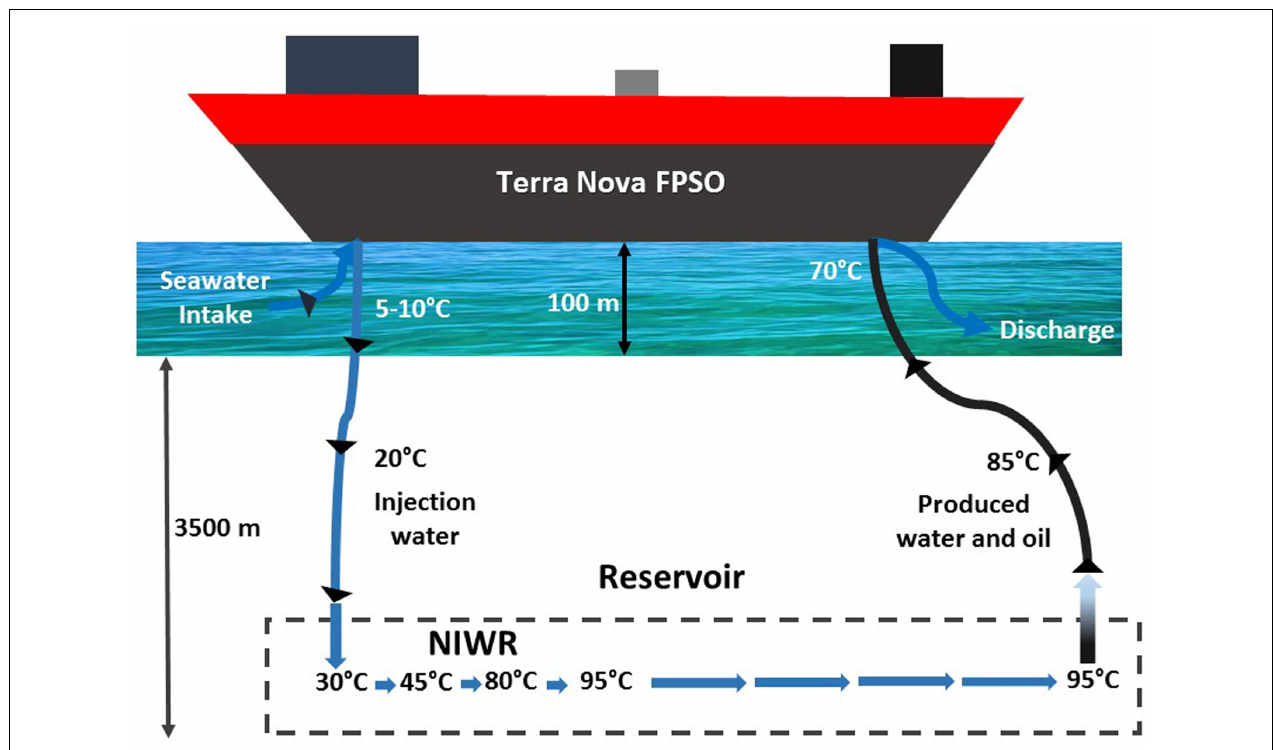
FIGURE 1 | Schematic of seawater injection from the Terra Nova Floating Production Storage and Offloading (FPSO) vessel, as explained in the text. The near injection wellbore region (NIWR) has mesophilic (30–45 ◦ C), thermophilic (45–80 ◦ C) and abiotic (80–95 ◦ C)